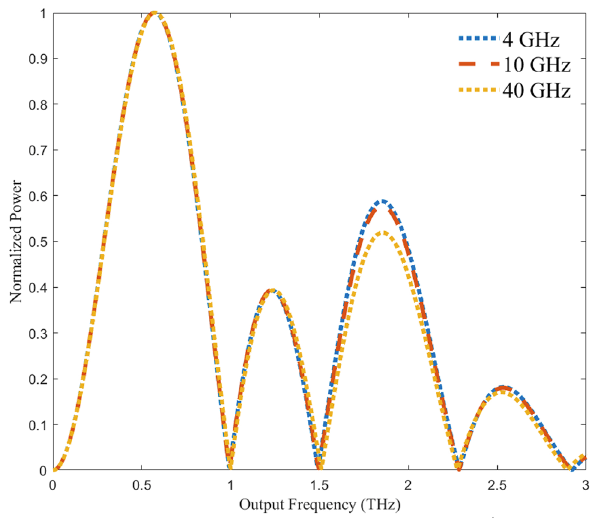
Figure 10. Effect of stimulus frequency on emission spectrum with 4 GHz, 10 GHz, and 40 GHz stimuli. Normalized spectra over the set of applied stimuli for the 0.5 THz design. For all stimuli, the shape is consistent. The 4 GHz and 10 GHz slightly overshoot the 40 GHz secondary peak at 1.8 THz.